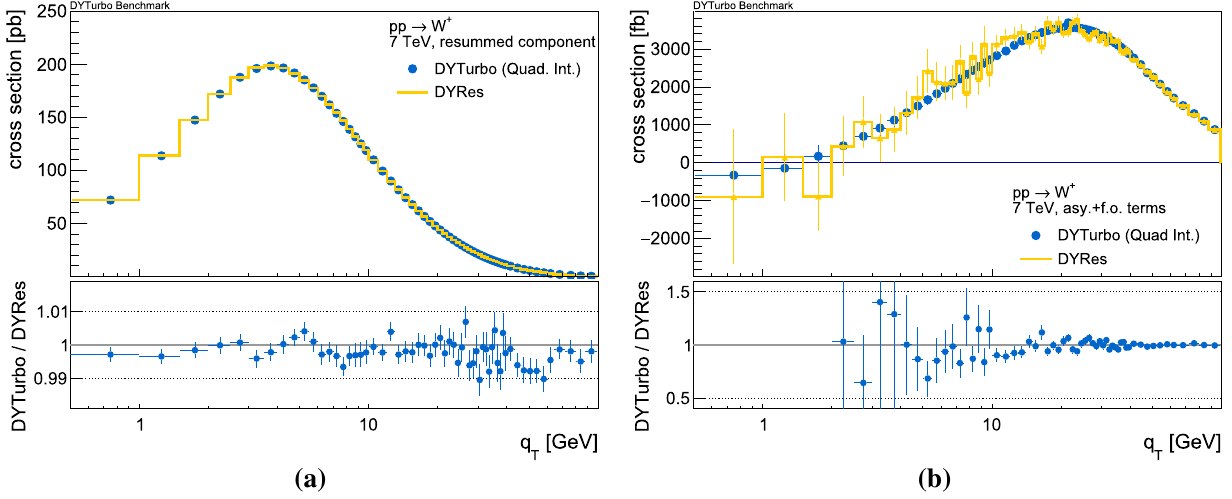
Fig. 7 Comparison of full-lepton phase space differential cross sec- tions computed with DYRes and DYTurbo (Quadrature integration √ s = 7 TeV as a function of the transverse momentum method) at of the positively-charged W -boson: a resummed component, b sum of